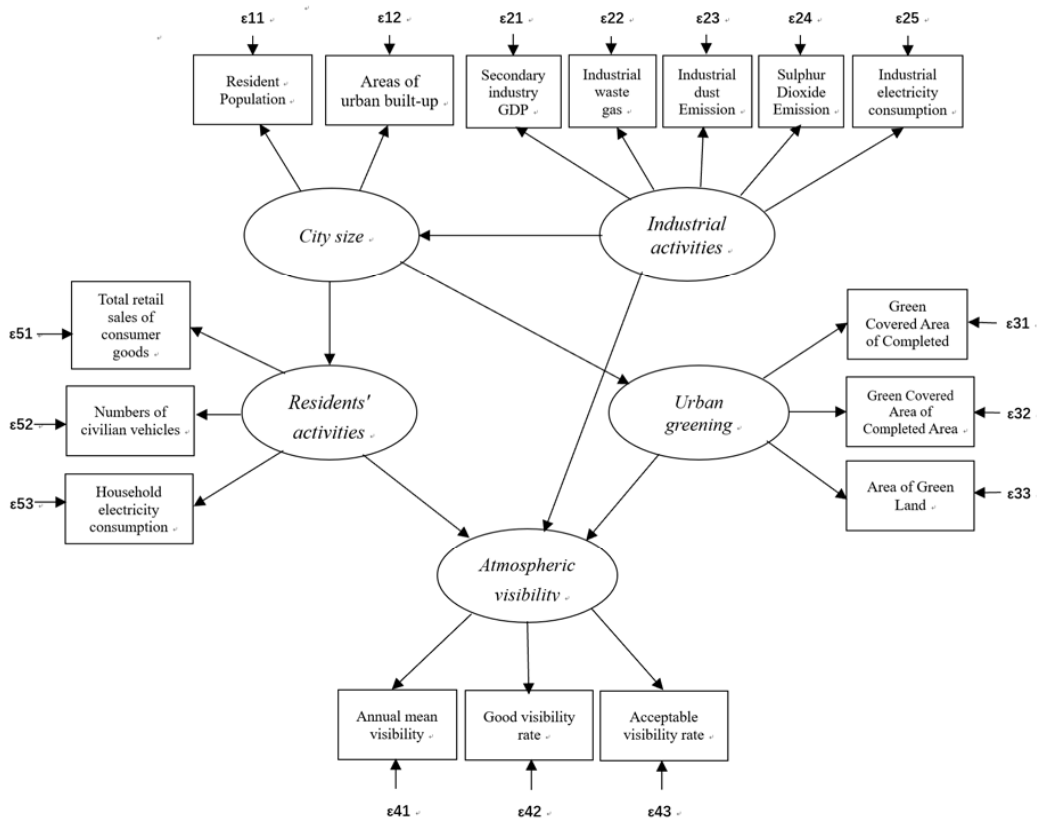
Figure 2. The initial model used for the study. The variables in rectangles are the observed factors; the variables in the ellipses are the latent variables; ε represents the errors of the observed factors.